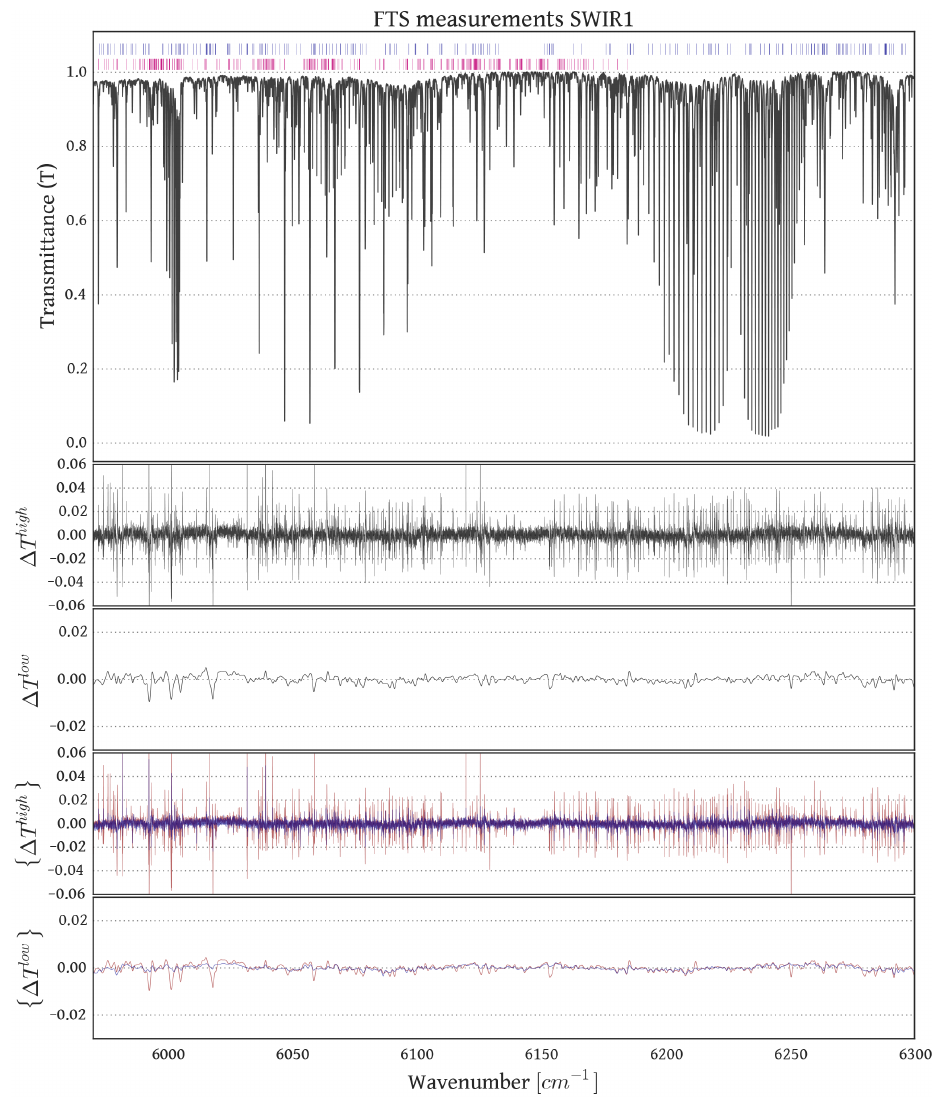
Figure 1. FTS transmittance spectrum in SWIR1 (upper panel), residual transmittance at FTS spectral resolution (first middle panel) and residual transmittance at S5/S5P spectral resolution (second lower panel). The last two panels show the average offour illustrative humid spectra (reddish lines) and four illustrative dry spectra (bluish lines) at FTS and S5/S5P spectral resolutions. The water vapor absorption lines (with line intensity ≥ 10 − 26 [moleccm − 2 ] ) are shown with blue vertical stacks. The methane absorption lines (with line intensity ≥ 10 − 23 [moleccm − 2 ] ) are shown with magenta vertical